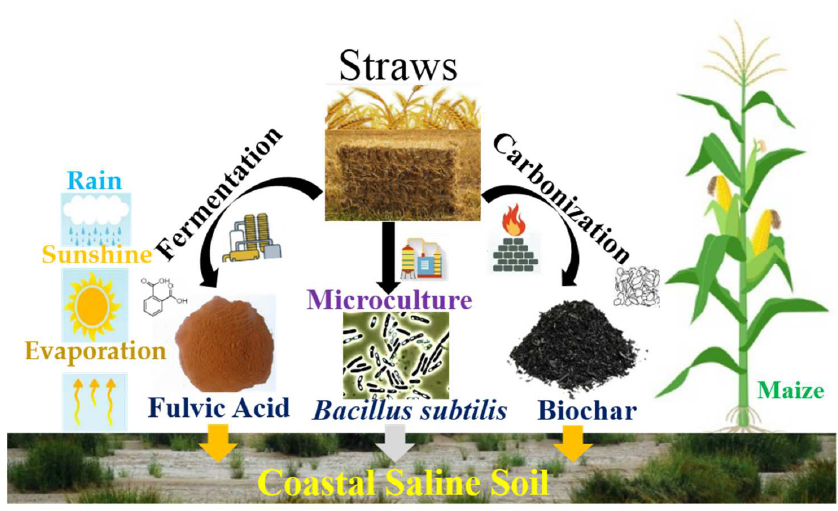
Figure 1. The experimental design of biomaterials obtained from straws for saline soil ameliora- tion.